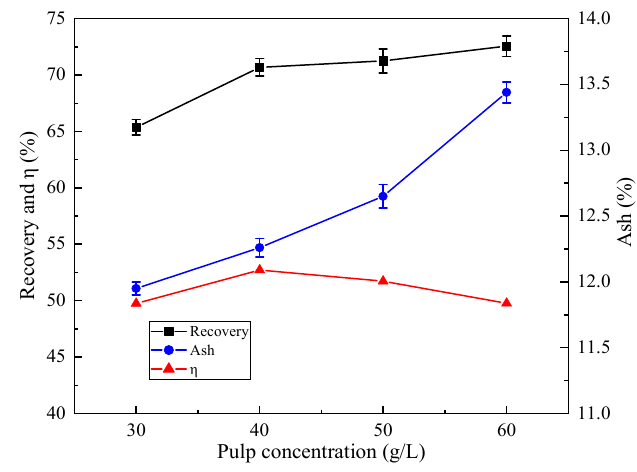
Figure 3. E ff ect of pulp concentration on flotation indices. Figure 3. Effect of pulp concentration on flotation indices. Figure 3. Effect of pulp concentration on flotation indices.